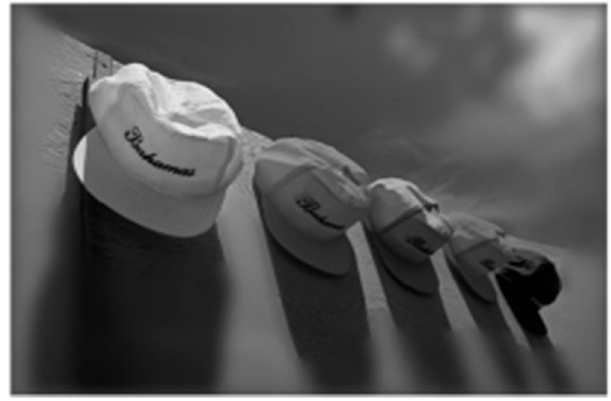
Figure 5. Damaged figure of non-interest region.